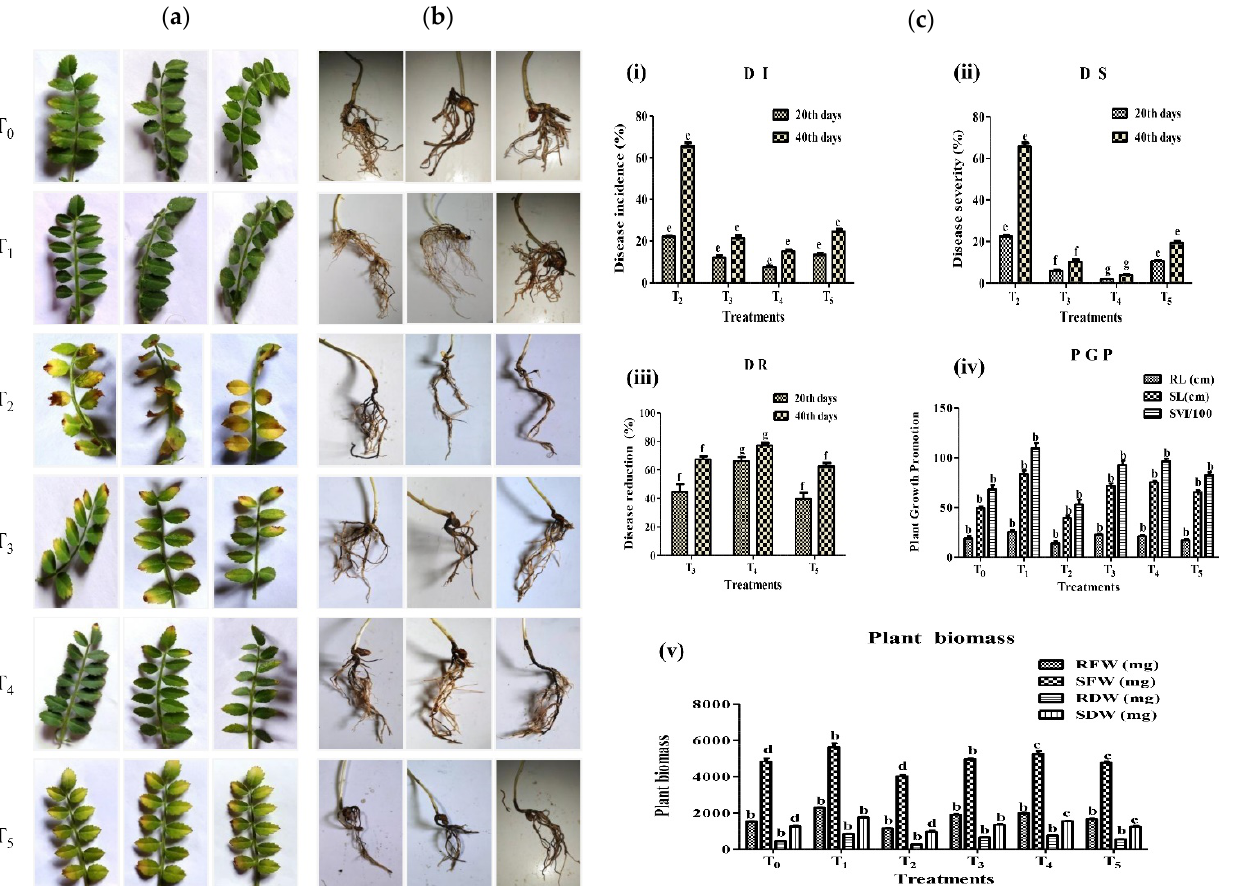
after 12, 24, 36, and 48 h of incubation. RL = Root Length, SL = Shoot Length, RFW = Root Fresh Weight, SFW = Shoot Fresh Weight, RDW = Root Dry Weight, SDW = Shoot Dry Weight, SVI = Seed Vigor Index and RRL = Root Relative Length. Values are expressed as means ( n = 3) ± Standard Error Mean (SEM). Each replicate consists of sixteen plants per jar. Statistical differences were ana- lyzed by two-way analysis of variances (ANOVA). Significant differences (c = p < 0.001, d = p < 0.01, e = p < 0.05 and f = p > 0.05, followed by Bonferroni Posttests) compared with the control.